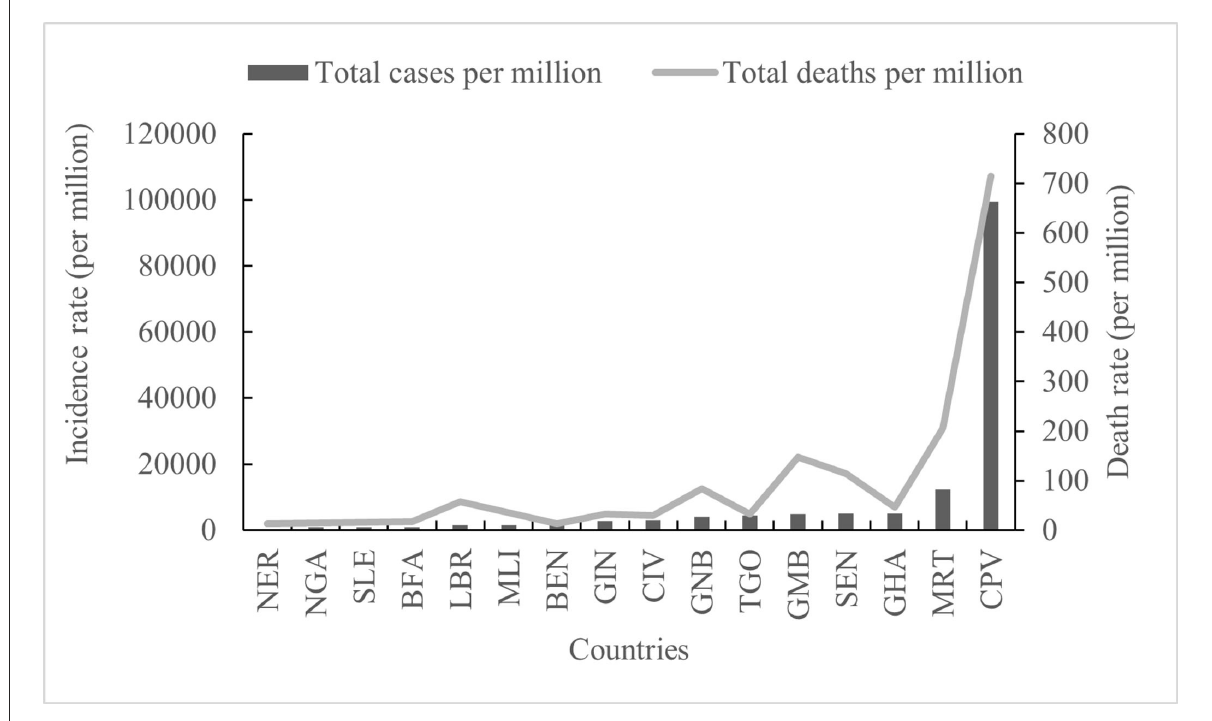
FIGURE4 Comparative analysis of the total of the cases and deaths per million in 16 countries in West